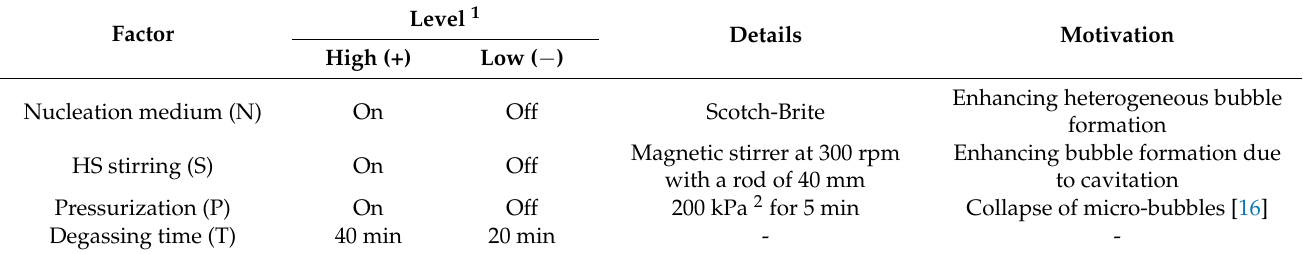
Table 1. Design factors of the screening experiment of degassing